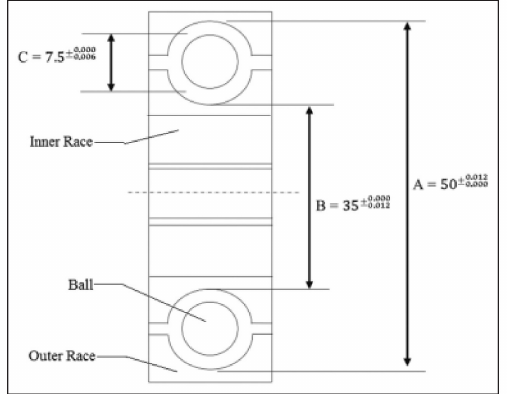
Figure 2. Ball bearing assembly (Lu and Fei (2015) [14]).